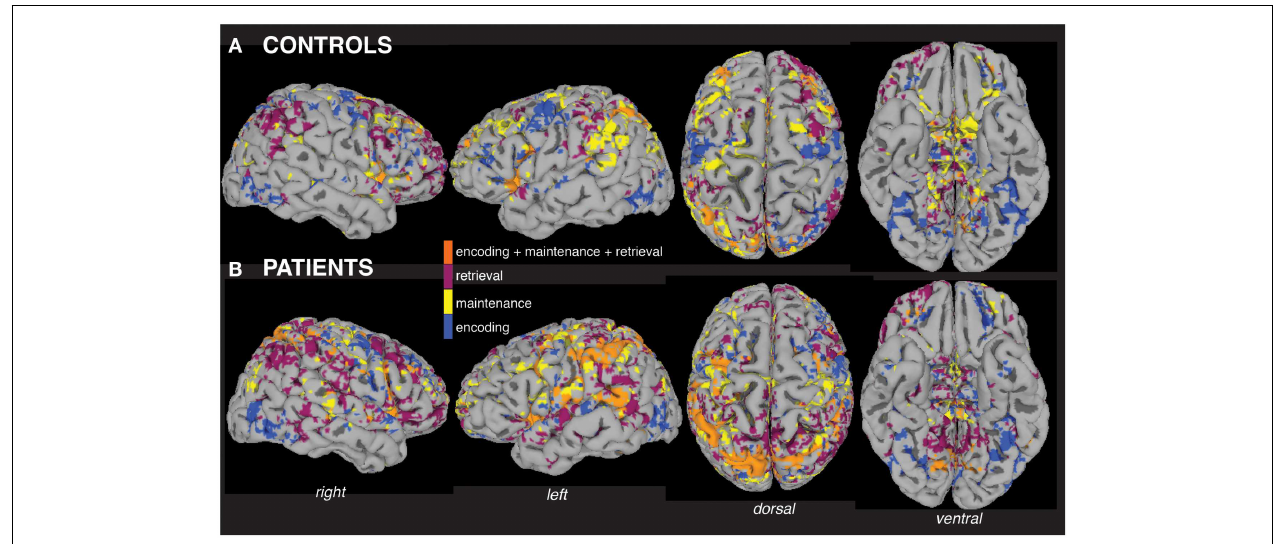
(A) and the group of controls (B) , including areas activated during all three periods (orange).The group maps are displayed for ease of comparison on a